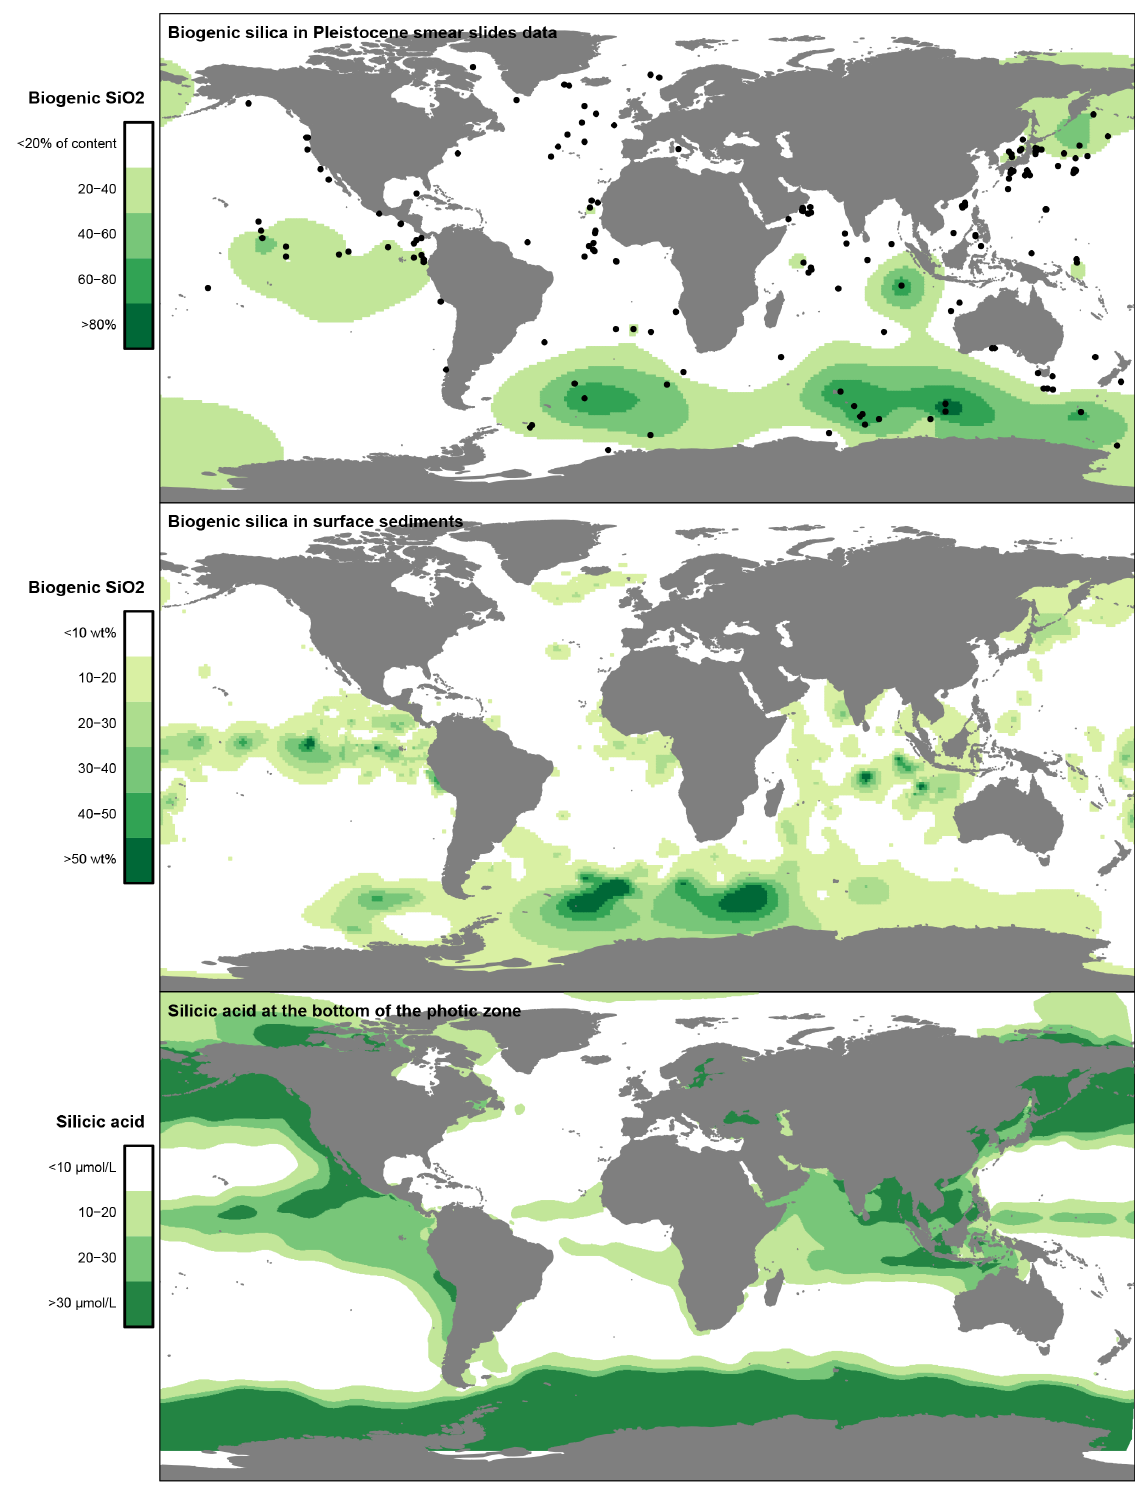
Figure 2. Comparison between smear slide-based data and reference data. Upper panel: cumulated distribution of diatoms, radiolarians, silicoflagellates and sponge spicules in the Pleistocene. Black dots are the siliceous microfossil-bearing sites present in the Pleistocene. Middle panel: biogenic opal in surface sediments from Archer (1996). Lower panel: silicic acid at 200m below the ocean’s surface (lower limit of the euphotic zone) from Garcia et al.